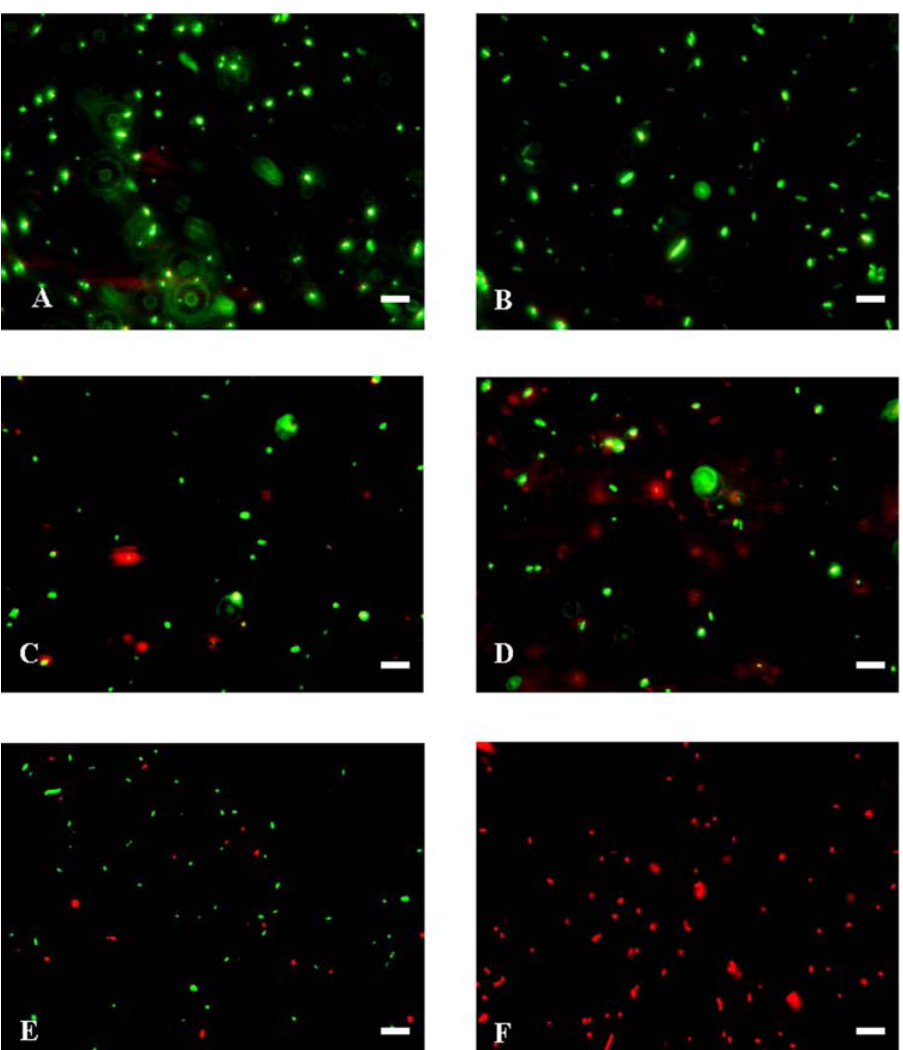
Figure 5. Fluorescence-based microscopic evaluation of the effect of squalamine on bacterial integrity and survival. E. Coli cultures (10 9 /mL) were either left untreated (A) or treated with increasing squalamine concentrations: 1.25 m g/mL (B), 2.5 m g/mL (C), 5 m g/mL (D), 10 m g/mL (E), 100 m g/ml (F). Suspensions of cultured E. Coli were then stained with the Live/Dead BacLight bacterial Viability kit, as described in material and methods. Scale bar (10 m